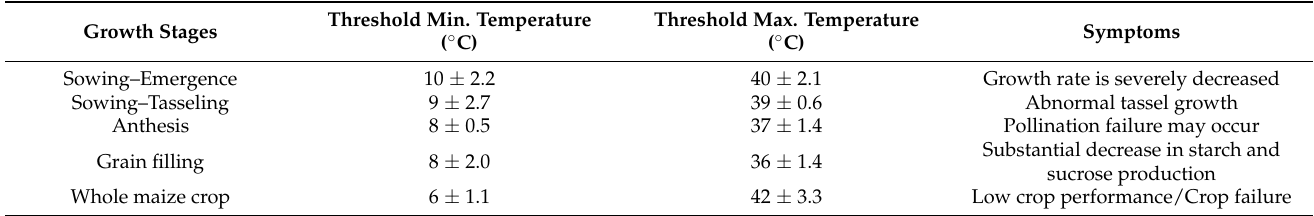
Table 1. Threshold temperatures for different growth stages in